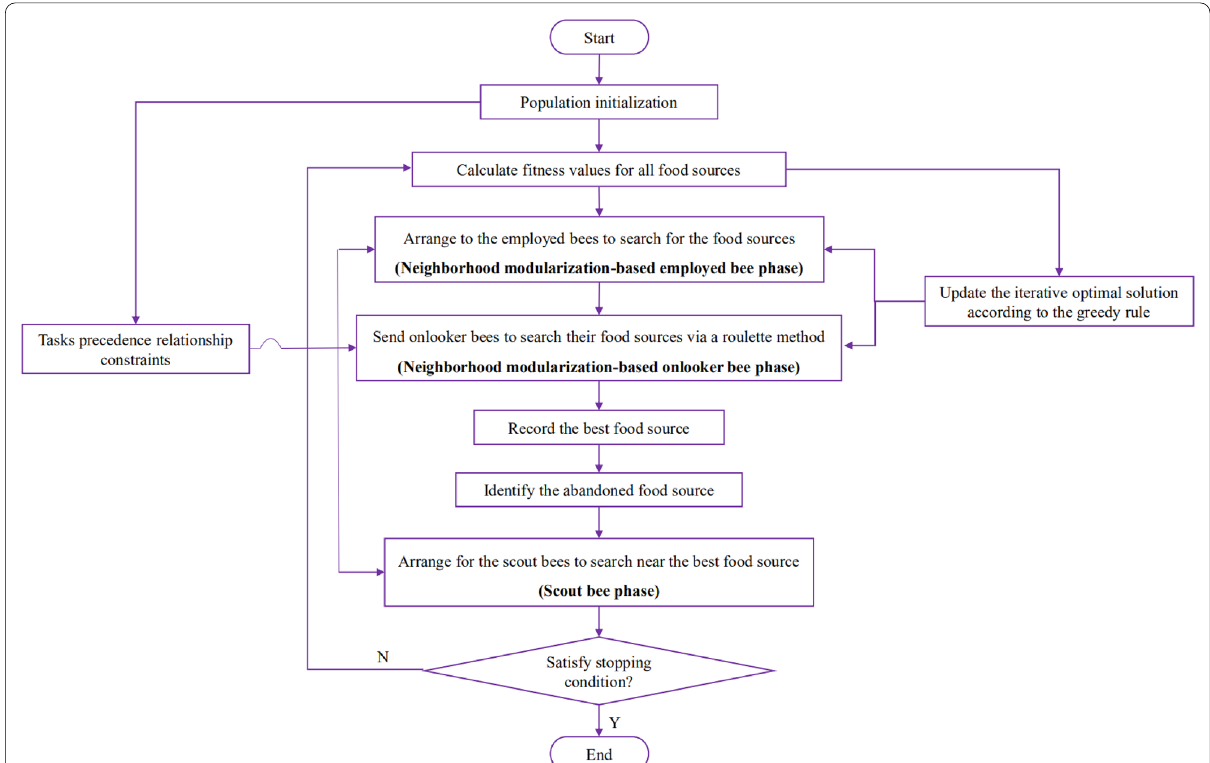
Figure 2 The procedure of